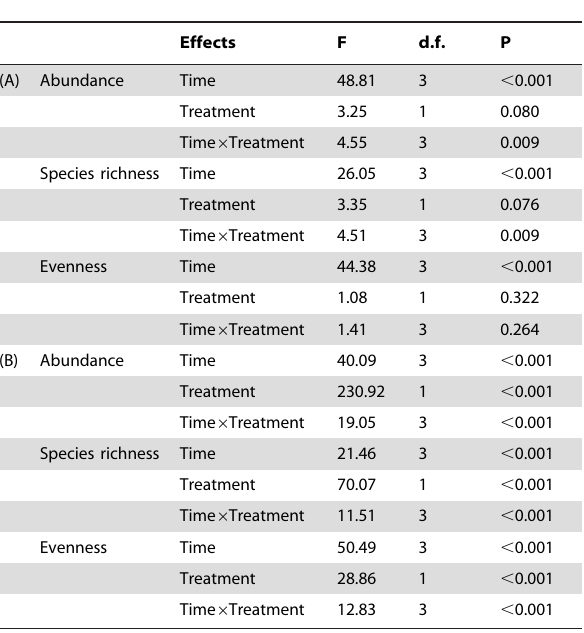
Table 2. Effects of carcass treatment, time, and their interaction on (A) ant and (B) beetle abundance, species richness and